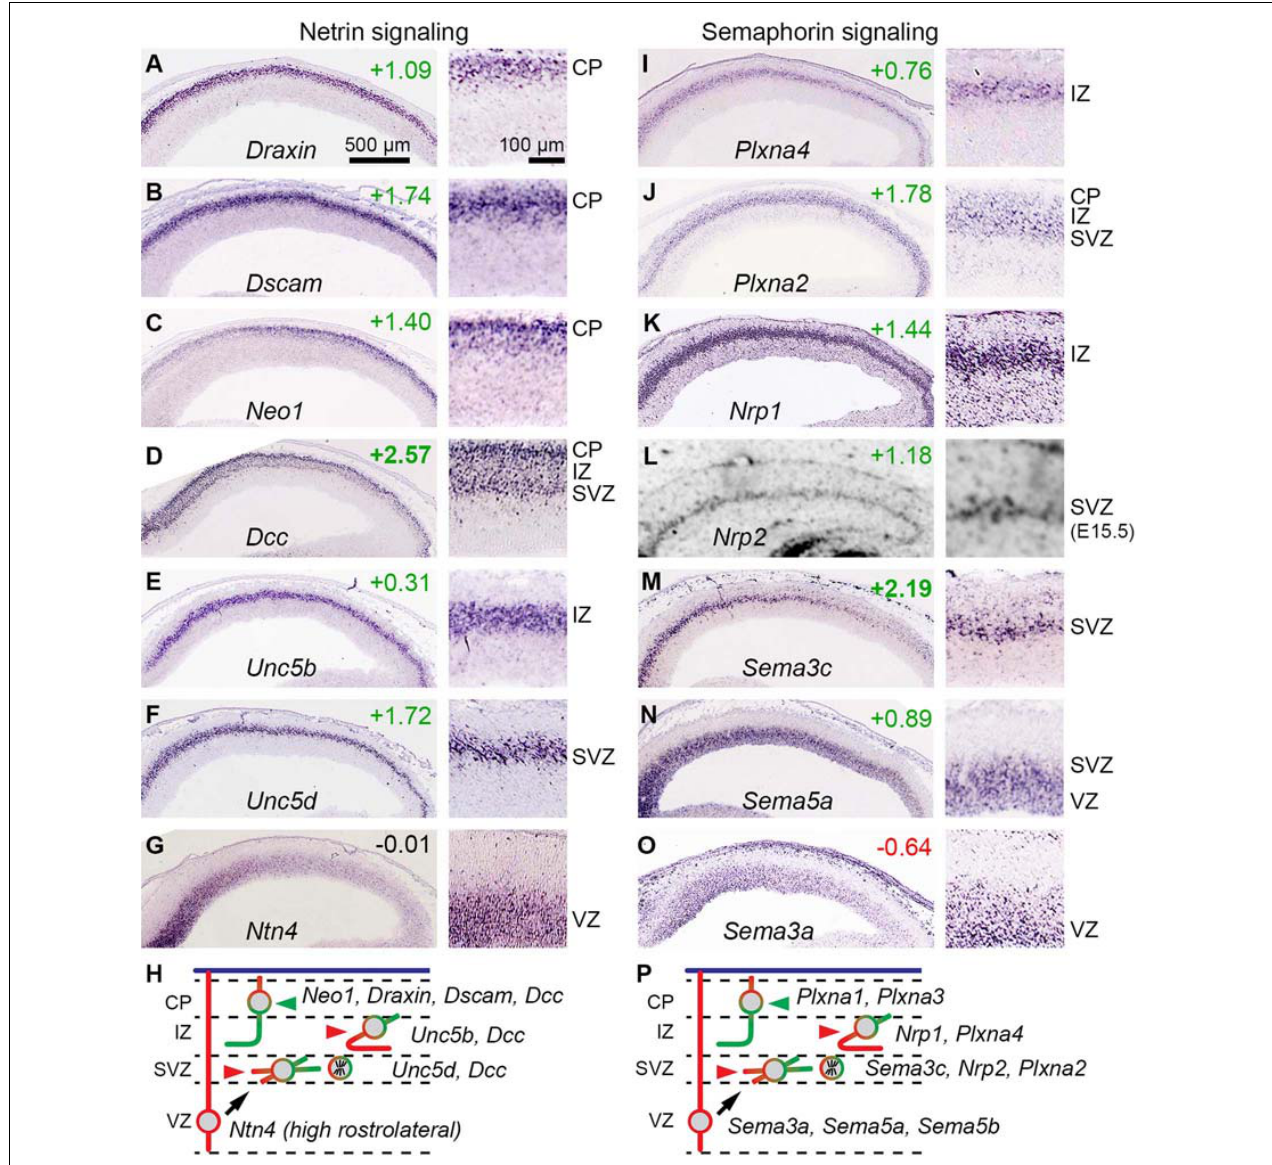
FIGURE 8 | Netrin and semaphorin signaling involving IPs. (A–G) Expression of selected netrin signaling molecules, including bIP-selective Unc5d (F) . Each panel shows low (left) and high (right) magnification views of cortex; rostral is to the left. (H) Proposed model for netrin signaling involving Ntn4 from RGPs in a high rostral gradient, and responsive PNs in each histologic zone. (I–O) Expression of selected semaphorin signaling molecules, including bIP-selective genes Plxna2 (J) , Nrp2 (L) , and Sema3c (M) ; and abIP-selective Sema5a (N) . (P) Proposed model for semaphorin signaling among cell